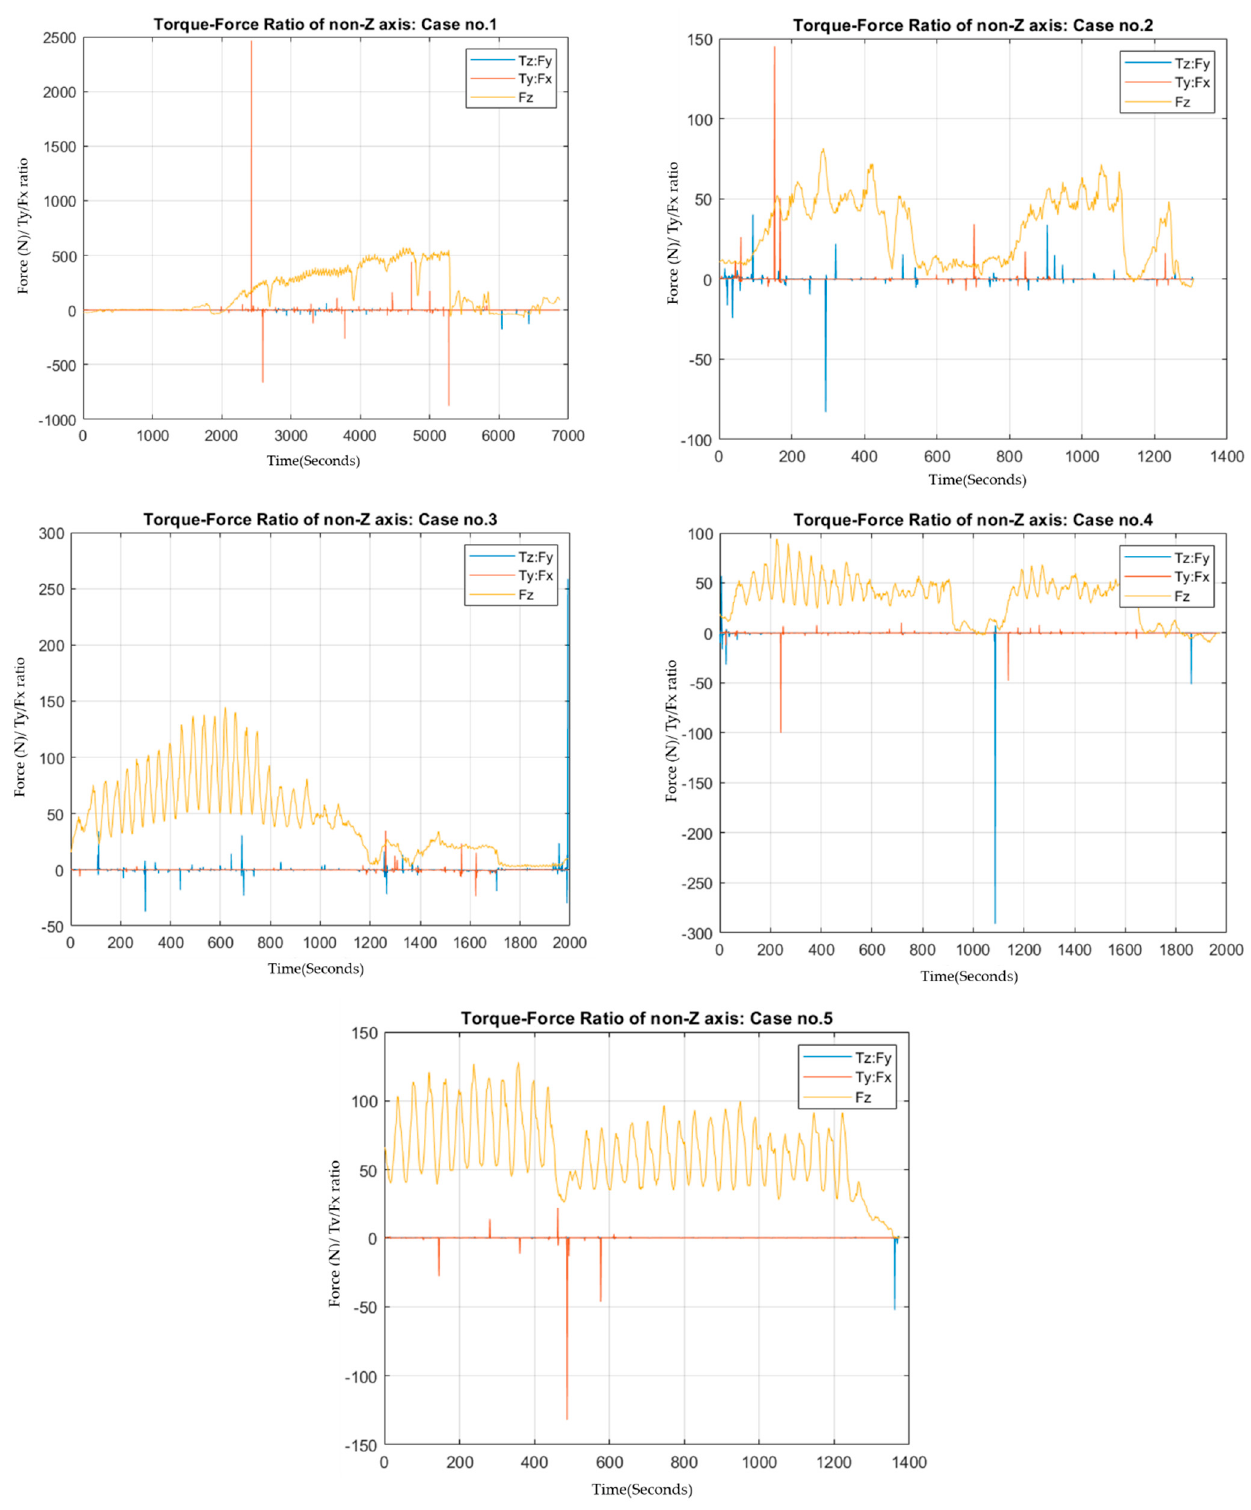
Figure 6. Force on z − axis according to time with torque to force ratio on non − z − axes through time. The magnitude of force was multiplied for better visualization.